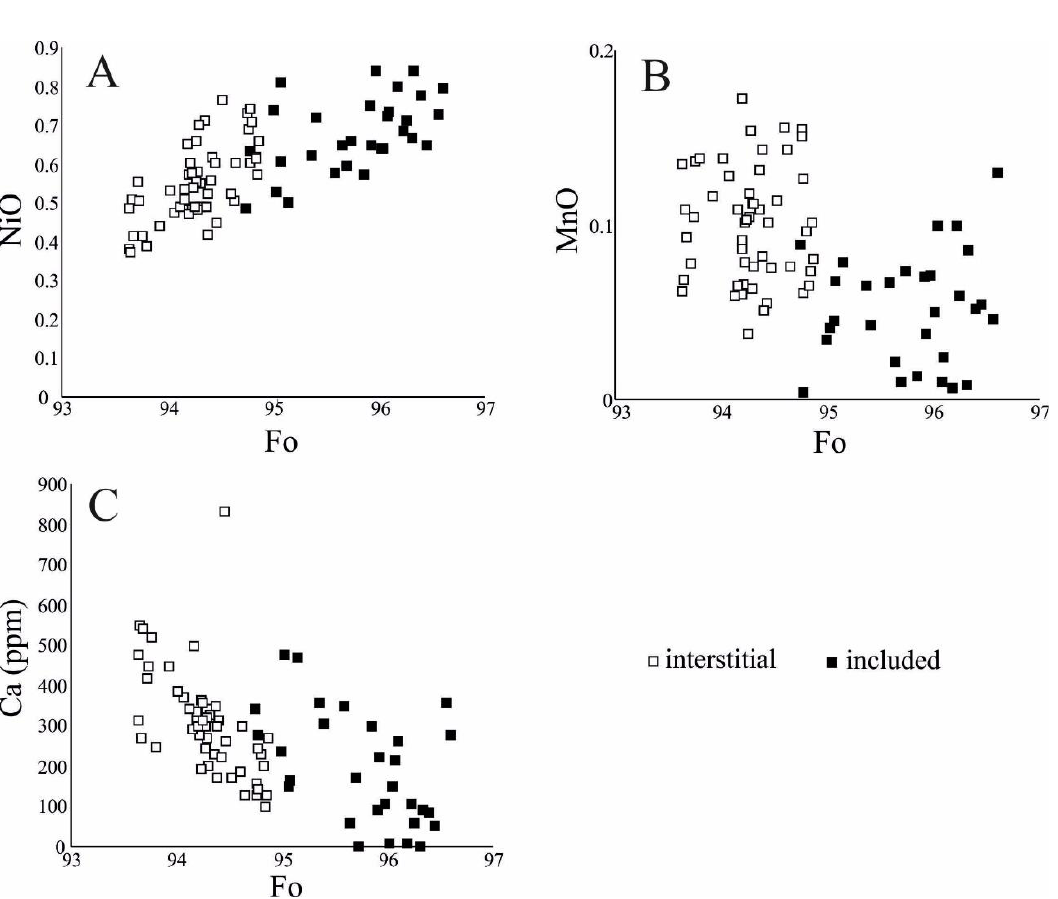
Figure 8. Compositional variation of NiO (wt%) ( A ), MnO (wt%) ( B ), and Ca ( C ) as a function of forsterite molar % in the olivine from Kabaena Island chromitites. Table 2. Selected microprobe analyses of olivine (wt%) from chromitites of the Kabaena Island oph- iolite.